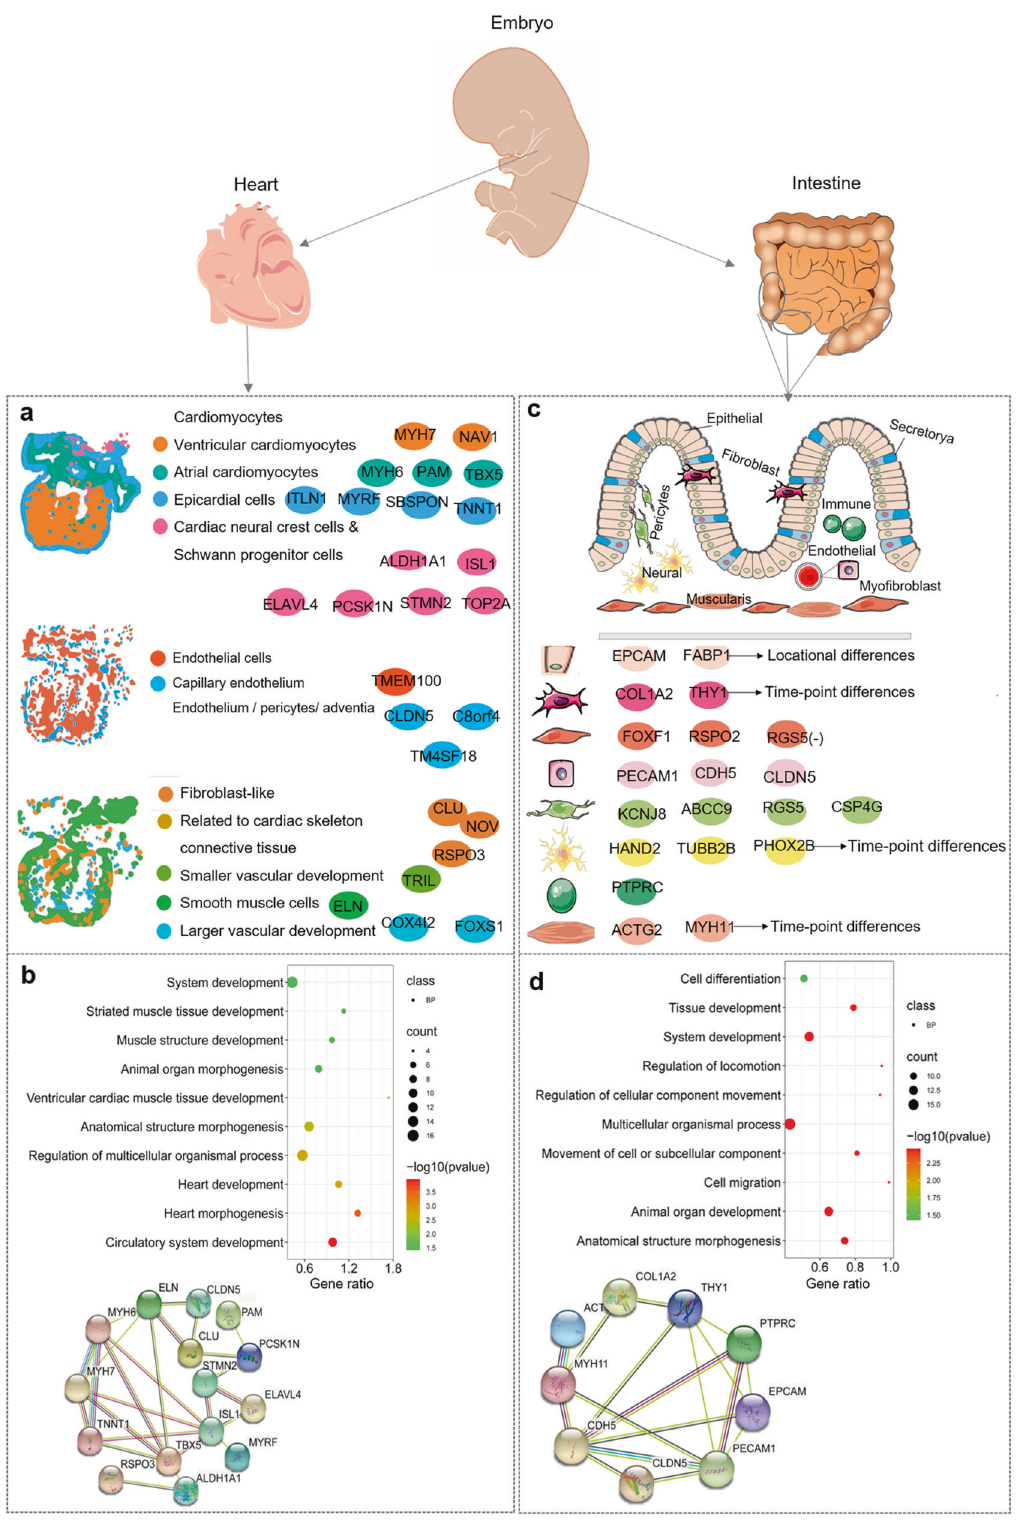
microenvironment and are responsible for tumor progression and complexity. 110 ST pro fi les of various diseases were mapped, including within brain tissue, 92 spinal cord tissue, 95 breast cancer, 5 cutaneous malignant melanoma, 89 prostate cancer, 88 gingival tissue, 108 pancreatic tissue, 14 and human heart tissue. 109 Moncada